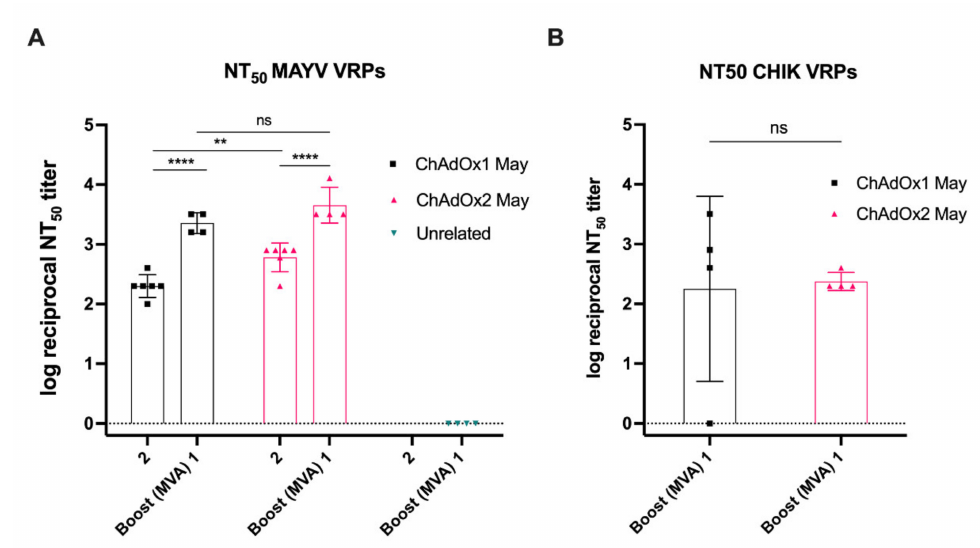
Figure 6. MAYV and CHIKV neutralisation assays. ( A ) MAYV NT 50 titers for BALB/c mice serum samples 2 weeks post-prime immunisation with ChAdOx1 or ChAdOx2 May or unrelated ChAdOx1 NS vaccine. NT 50 titers 1 week post MVA boost are shown. ( B ) CHIKV NT 50 titers for ChAdOx1/MVA May and ChAdOx2/MVA May are shown. Coloured lines represent the mean with SD and error bars. p values in ( A ) were determined by one-way ANOVA and Tukey’s multiple comparisons test. p > 0.05 (ns), p < 0.01 (**), and p < 0.0001 (****). p value in ( B ) was determined by the Mann-Whitney U test. p > 0.05